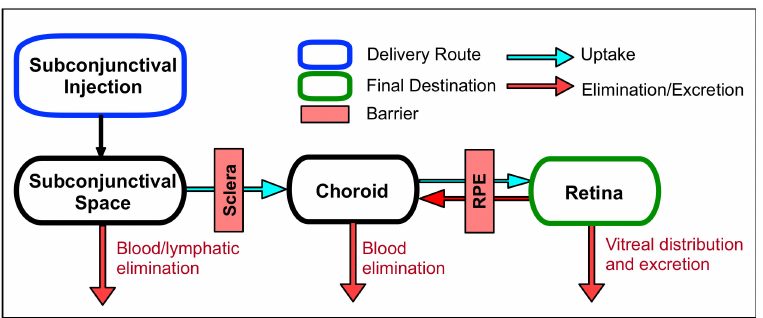
Figure 4. Drug pathway after subconjunctival injection. Drug in the subconjunctival space can reach the retina by passing through sclera and retinal pigment epithelium (RPE)